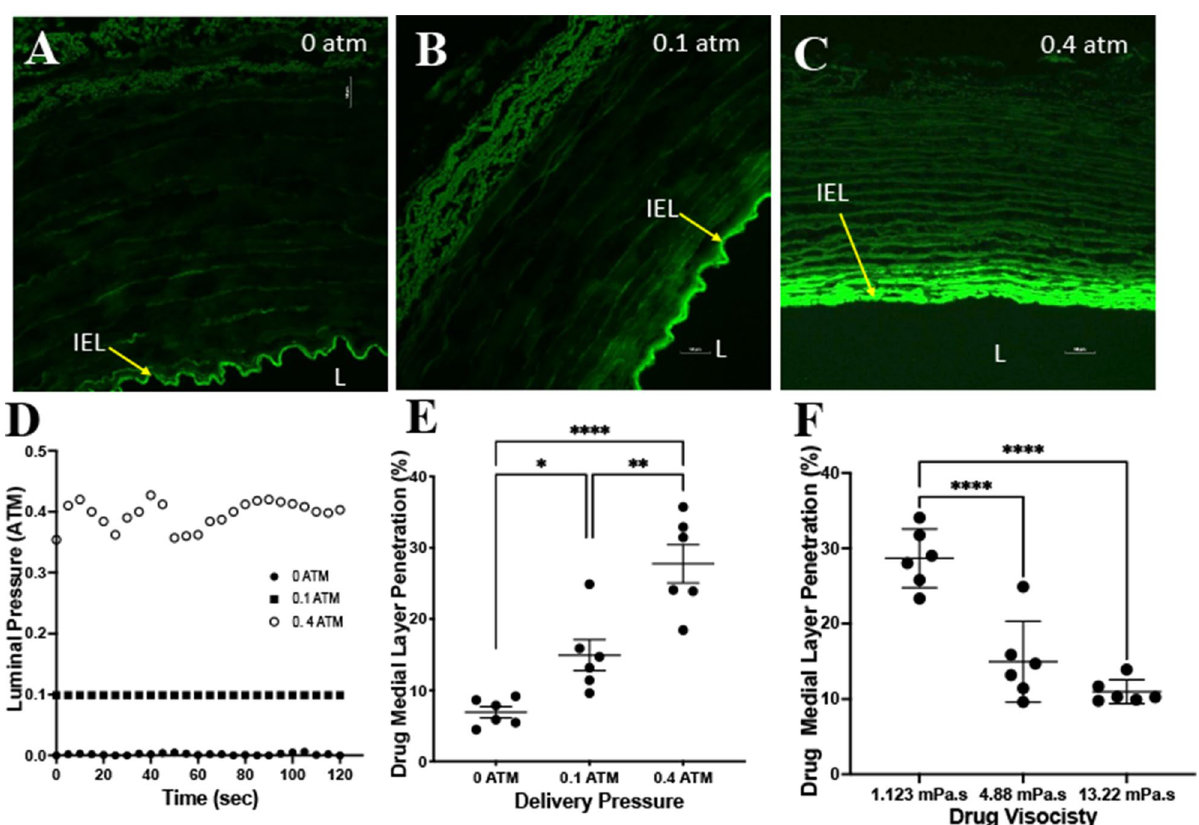
Figure 2. Ex vivo results of varying pressures and viscosities. ( A – C ) Representative confocal images demonstrating the penetration of the fluorescent drug at luminal pressures of 0 atm, 0.1 atm and 0.4 atm. Yellow arrow denotes the internal elastic lamina (IEL) and L represents the lumen of the artery. ( D ) Representative luminal pressure measurements during the two-minute drug delivery. ( E ) Drug medial layer penetration comparisons between the varying luminal pressures. ( F ) Drug medial layer penetration comparisons between varying liquid drug viscosities. *P < 0.05, **P < 0.01, ****P < 0.0001, n = 6.